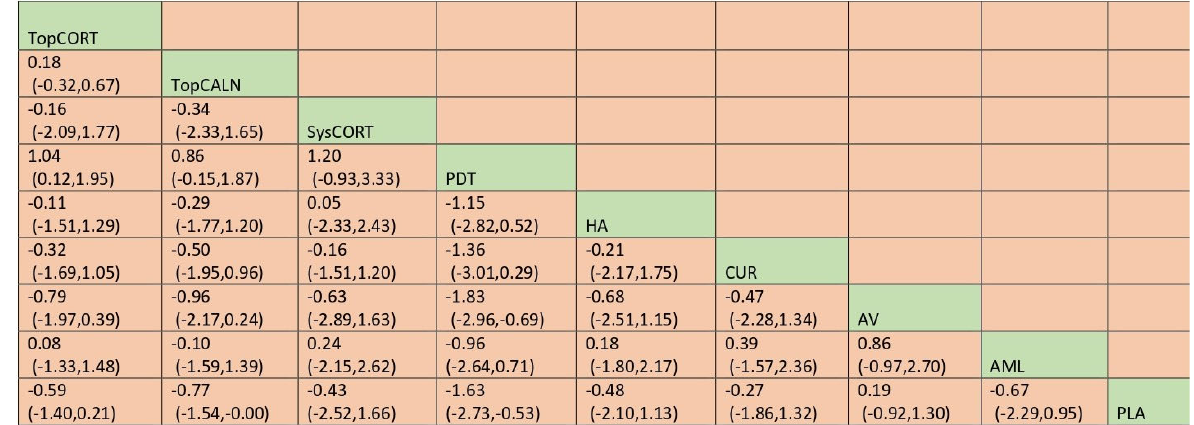
Figure 13. League table for pain score. Abbreviations: AML, amlexanox paste; AV, aloe vera; CUR, curcumin gel; PDT, photodynamic therapy; PLA, placebo; PUR, purslane; SysCORT, systemic corticosteroid; TopCALN, topical calcineurin; TopCORT, topical corticosteroid; HA, hyaluronic acid. The green highlights indicate the interventions and the dark highlights indicate the significant re ‐ sults.